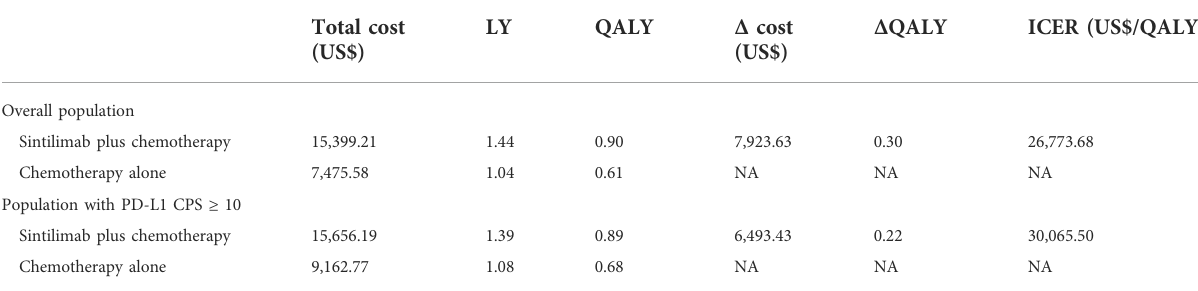
TABLE 5 Results for the cost utility